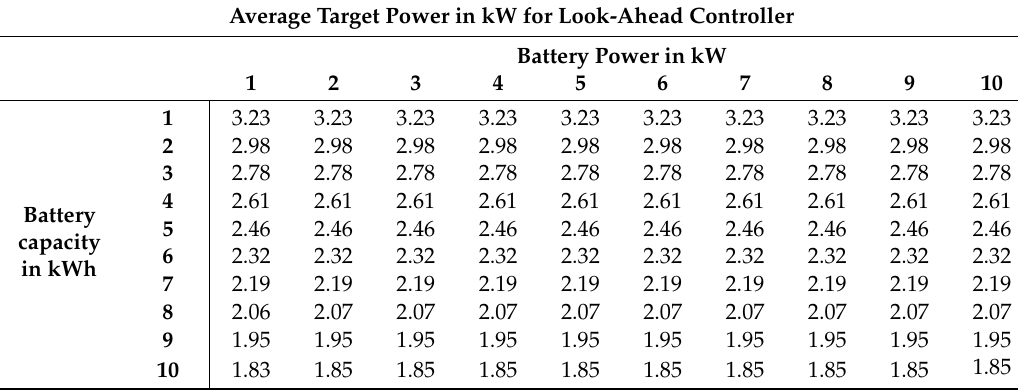
Table A1. Average target power in kW for look-ahead controller.